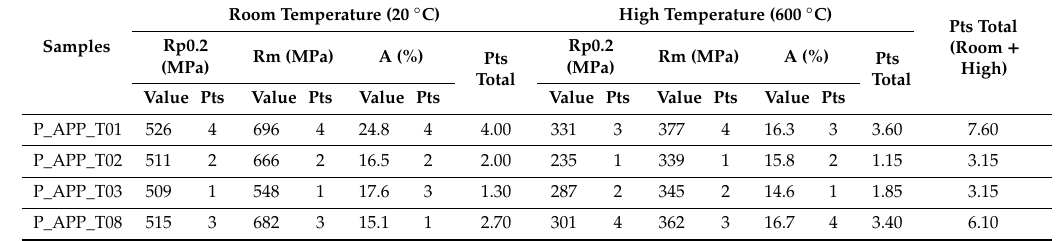
Table 11. Summary of the thermal cycles applied and corresponding results by test type.